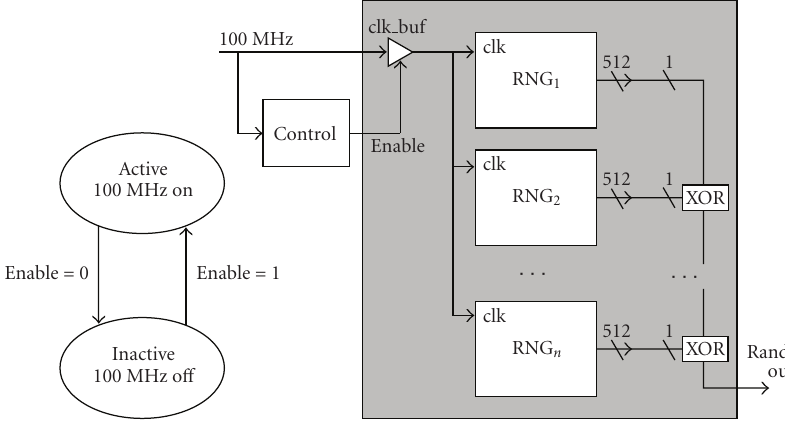
Figure 1: Fabric characterisation circuit implemented with random number generators.